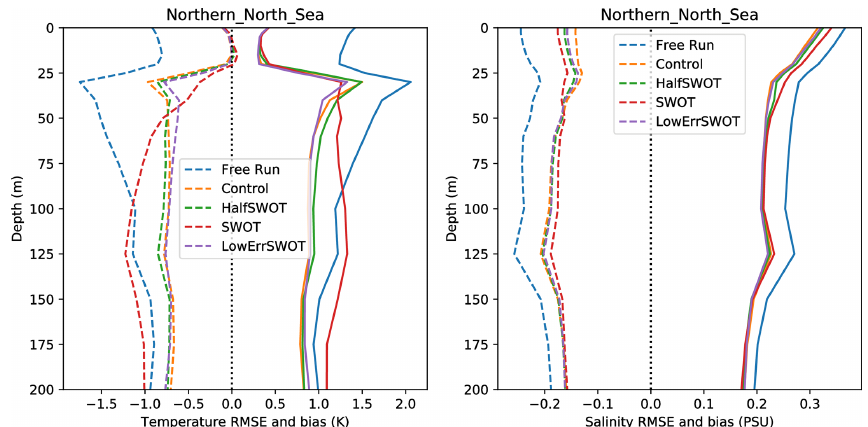
Figure 14. Northern North Sea temperature and salinity RMSE (solid) and bias (dashed) averaged over June–October when the full temper- ature and salinity balanced changes due to SSH assimilation are applied.